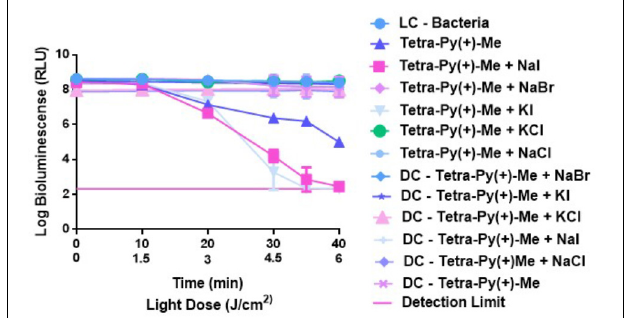
FIGURE 3 | Survival of bioluminescent E. coli during aPDT with Tetra-Py-(+)-Me at 5.0 µ M and 50 mM of KI, NaI, KCl, NaCl, and NaBr after irradiation with PAR white light (380–700 nm) at an irradiance of 25 W m − 2 for 40 min. The values are expressed as the three independent experiments; error bars indicate the SD and in some cases are collapsed with the